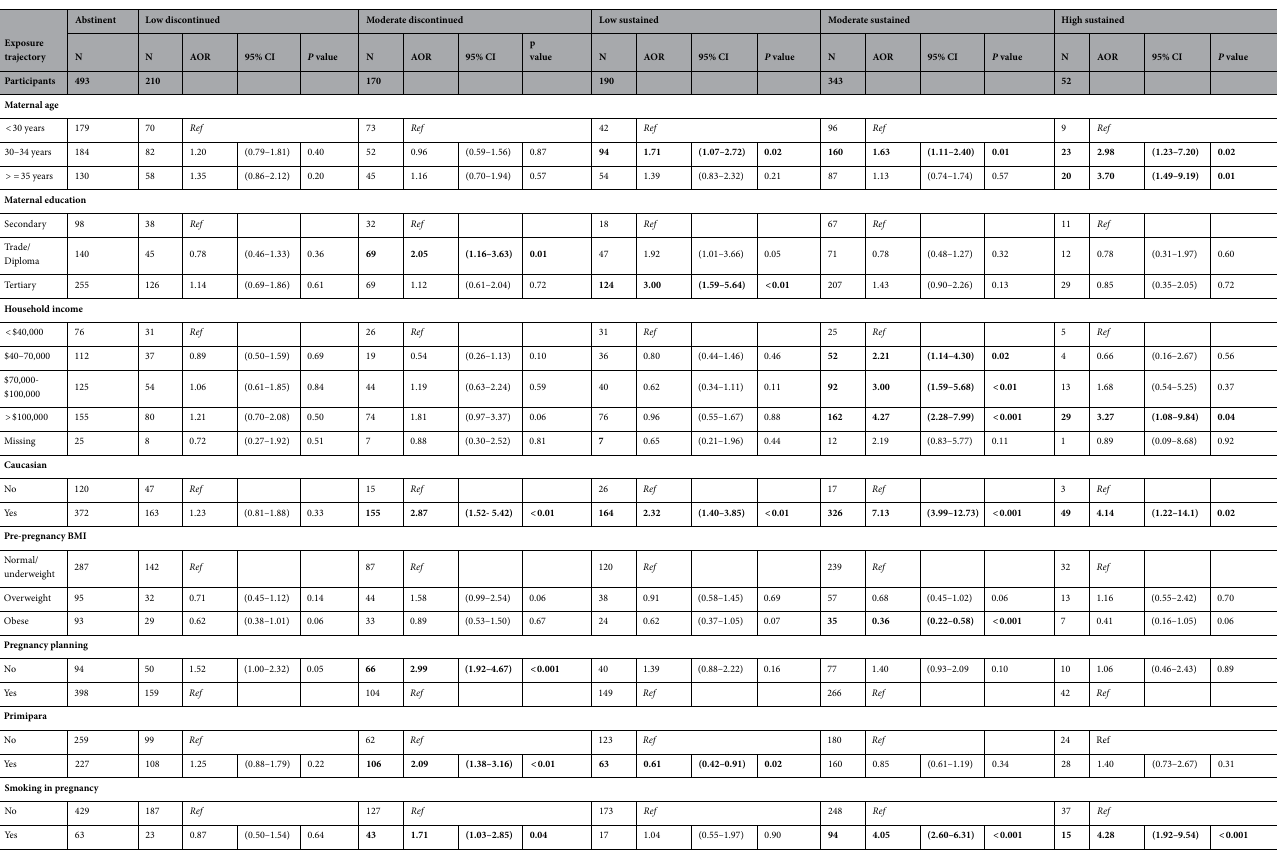
Table 4. Demographic and pregnancy-related characteristics predictive of trajectory. N: Sample size for multivariate analysis (i.e. number of cases with a complete set of predictors, except for income, where